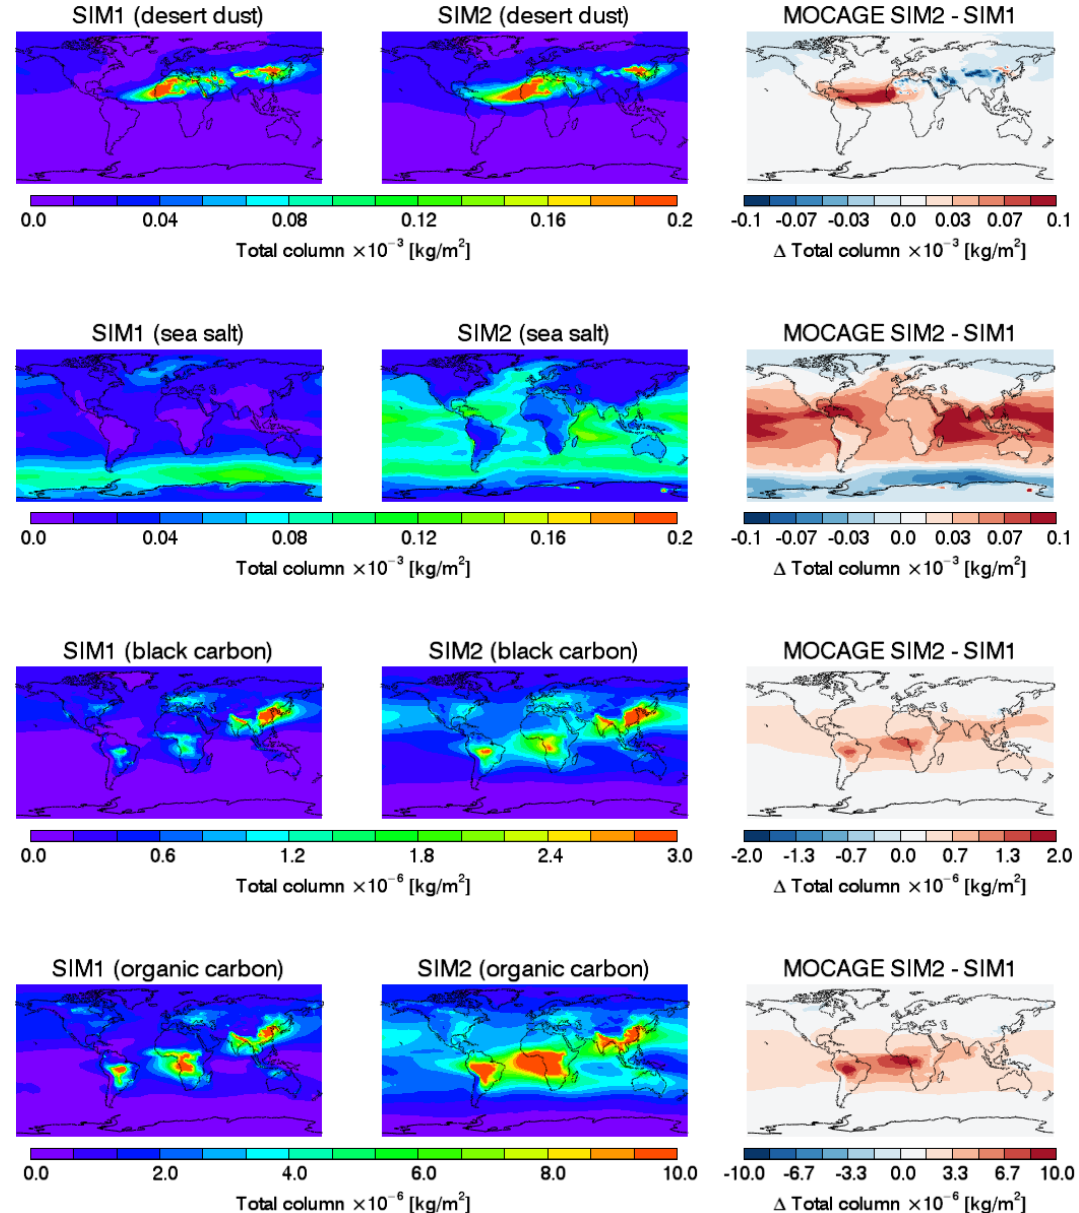
Figure 2. The geographic distribution of the mean annual burdens of all aerosol species in the CTM MOCAGE: for SIM1 on the left, for SIM2 in the middle, and their difference on the